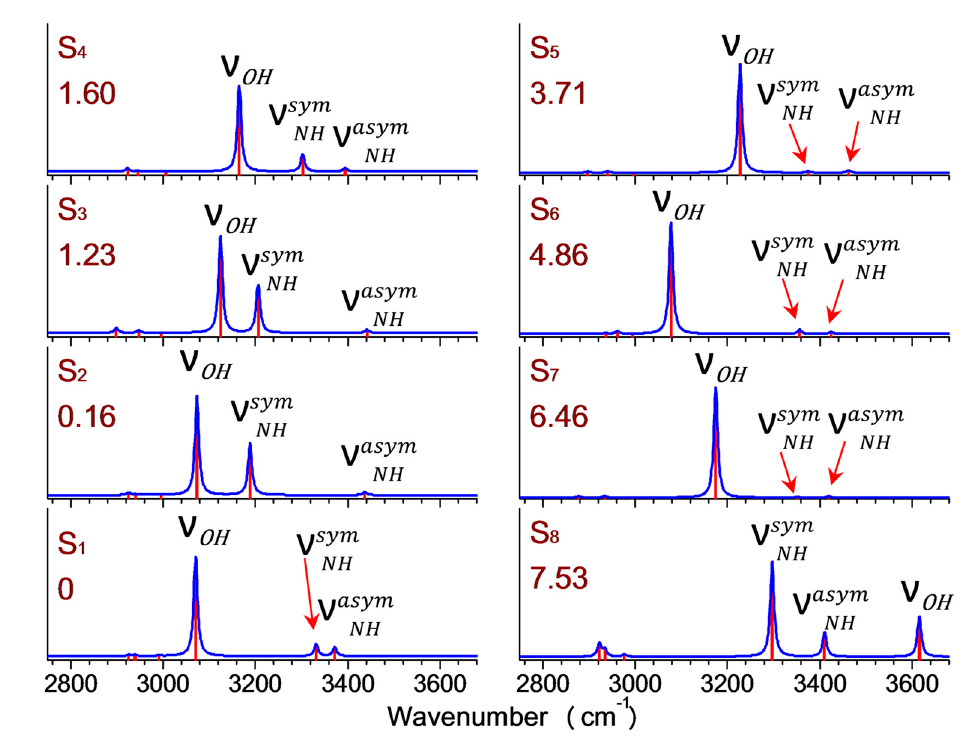
Figure 8. Simulated IR spectra at the level of CAM-B3LYP in the range of 2800 cm − 1 and 3700 cm − 1 for S i ( i = 1–8) (FWHM = 10 cm − 1 , scaled by 0.954) with their relative energies (kcal/mol)